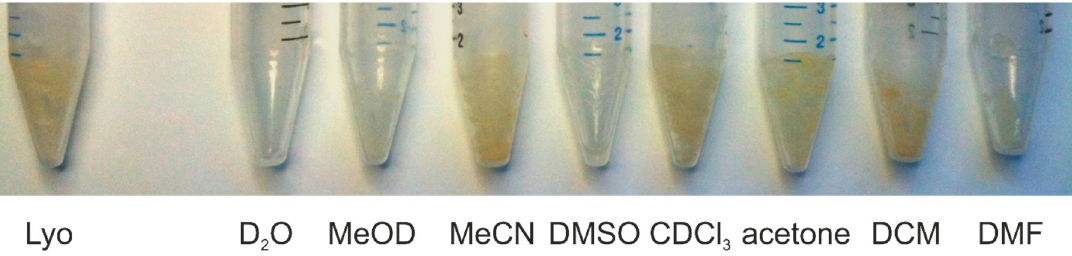
Figure 1. Residue of lyophilized urine samples before (Lyo) and after dissolution in various solvents. With D 2 O as the solvent, no residual remainders are visible, with MeOD, DMSO, and DMF a minor debris is visible and with MeCN, CDCl 3 , acetone, and DCM nearly no difference to the undissolved sample is visible, indicating substantially incomplete dissolution.